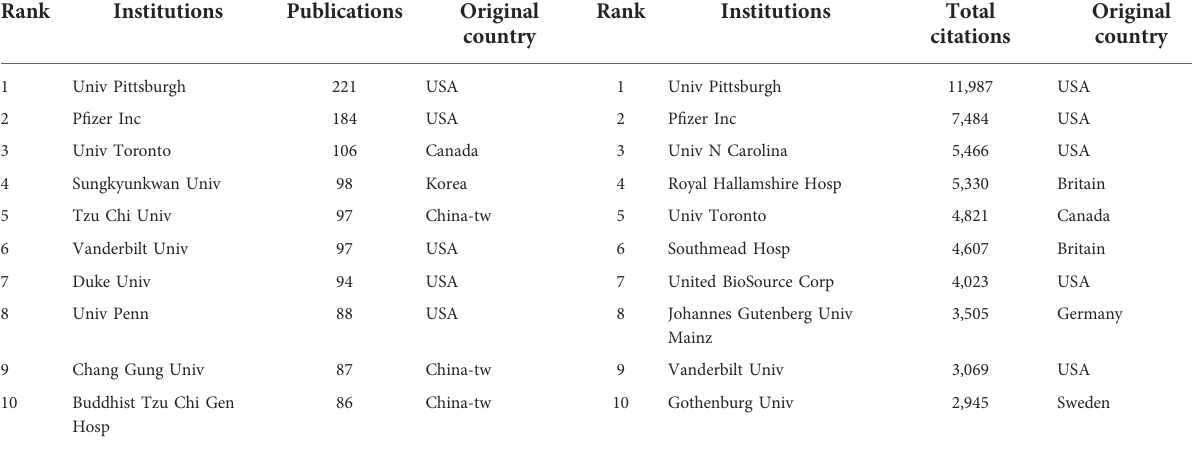
TABLE 2 Top 10 institutions publishing original human studies on the topic of overactive bladder. Rank